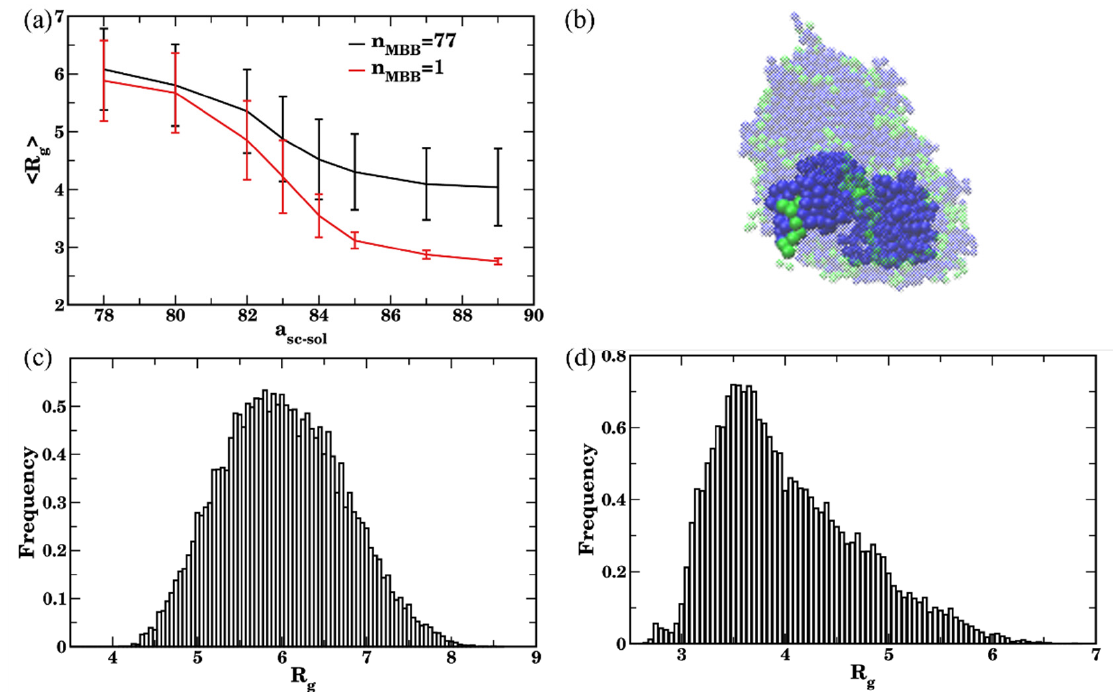
Figure 9. ( a ) Radius of gyration (<R g >) of bottlebrushes upon equilibration as a function of sidechains affinity for n MBB = 77 (black curve) and for the single bottlebrush (red curve). The values are averaged over all n MBB = 77 bottlebrushes in four independent simulation sets within last 3 × 10 5 timesteps (60 frames for each set), error bars represent standard deviation. ( b ) Representative snapshot highlighting a single bottlebrush that is a part of the larger cluster (a sc-sol = 89, t = 10 5 ). ( c , d ) Distribution of R g in good solvent a sc-sol = 78 (in ( c )) and in poor solvent a sc-sol = 89 (in ( d )) for n MBB = 77 bottlebrushes in four sets within the last 3 × 10 5